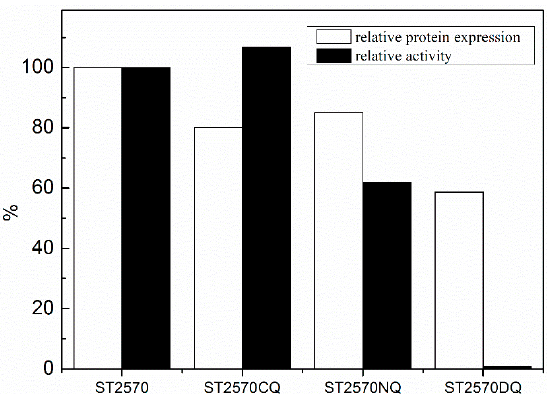
Figure 1. Effect of the fused aldehyde tag on the expression level and activity of the recombinant protein ST2570.